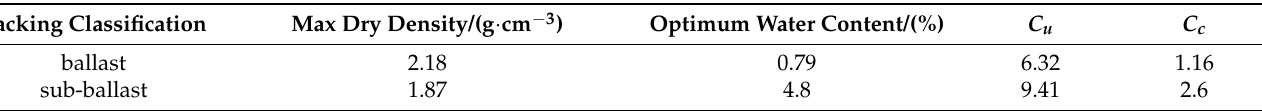
Figure 3. Test ballast and sub-ballast grain size gradation curves. Table 1. Physical properties of ballast and sub-ballast.